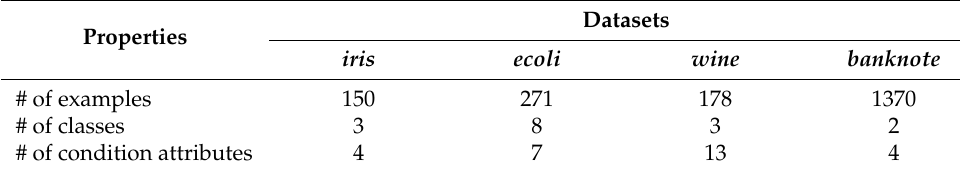
Table 1. Descriptions of the tested datasets in this